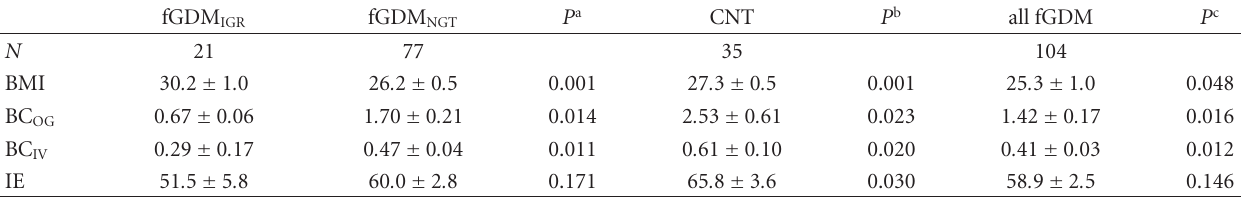
Table 2: Beta-cell function from OGTT (BC OG ) and IVGTT (BC IV ) and incretin e ff ect (IE) in all fGDM and in the two subgroups of fGDM characterized by normal glucose tolerance (fGDM NGT ) and impaired glucose metabolism (fGDM IGR ), compared to women who had normal pregnancy (CNT). fGDM IGR fGDM NGT P a